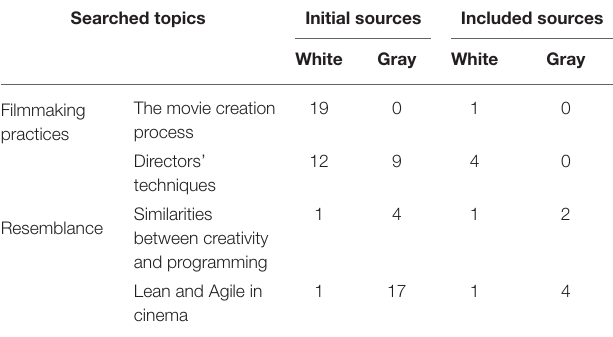
TABLE 4 | Number of sources per